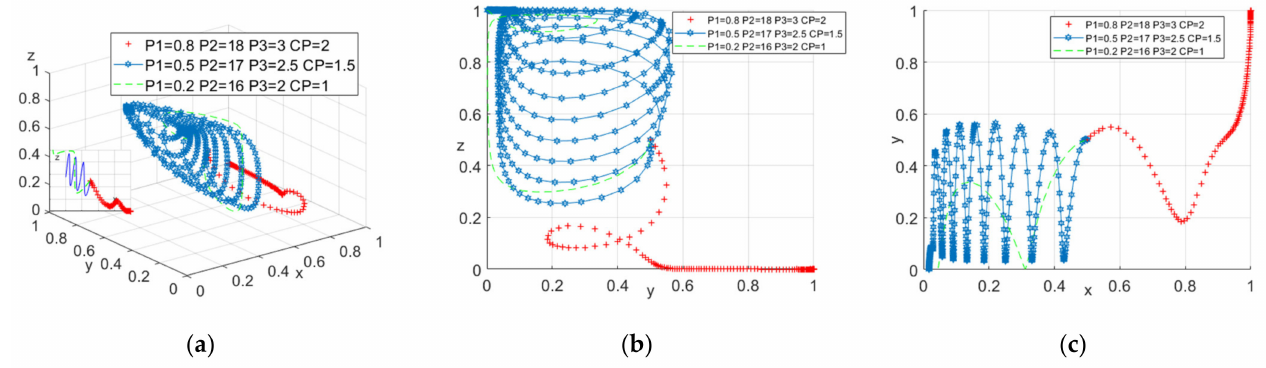
Figure 5. ( a ) Tripartite strategy; ( b ) Government–construction units; ( c ) Construction units–construction workers.